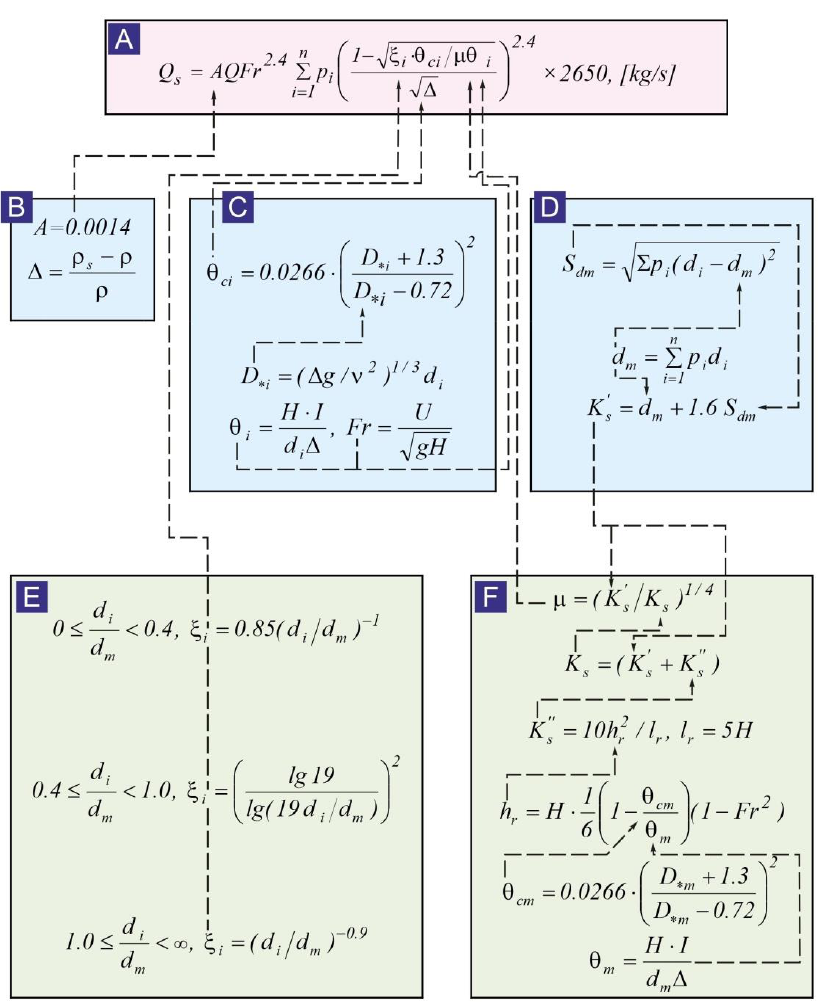
Figure 1. The modified sediment transport rate of van Rijn’s formula [ 31 - modified] — Box A, with